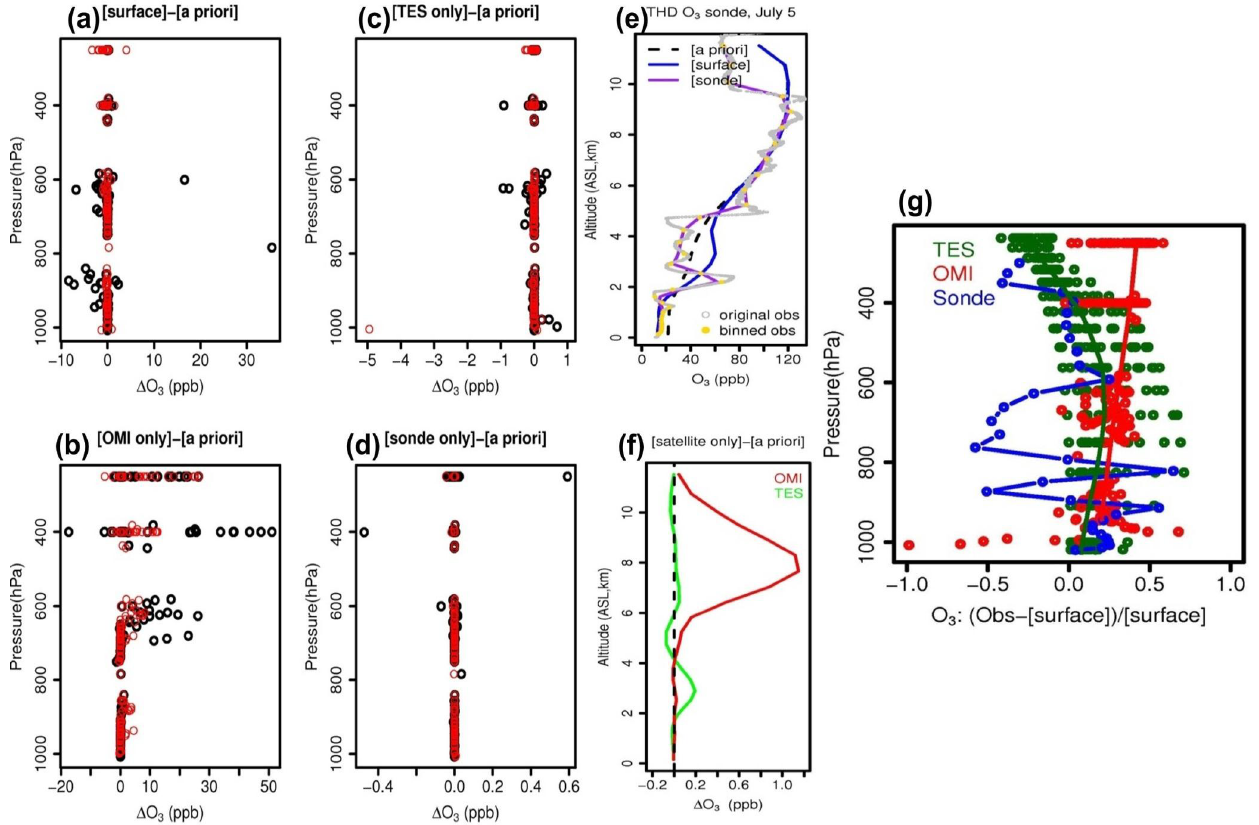
Fig. 15. Impacts of DA in the vertical. O 3 differences at selected OMI sampling locations: (a) Case AS-STEM a priori; (b) Case AO-STEM a priori; (c) Case AT-STEM a priori; (d) Case AD-STEM a priori. In (a–d) , black dots compare the raw data in OMI pressure grids and red dots compare the results after applying the OMI observation operator. (e) O 3 vertical profiles at THD on 5 July from sondes, STEM a priori, Cases AS and AD; (f) O 3 differences between Cases AT and AO and STEM a priori; (g) Comparison between measurements and the assimilated O 3 in Case AS, at corresponding measurement locations. This is used to quantify the upper limits of satellite uncertainties, with the assumption that Case AS provides the “best” O 3 distributions over the model